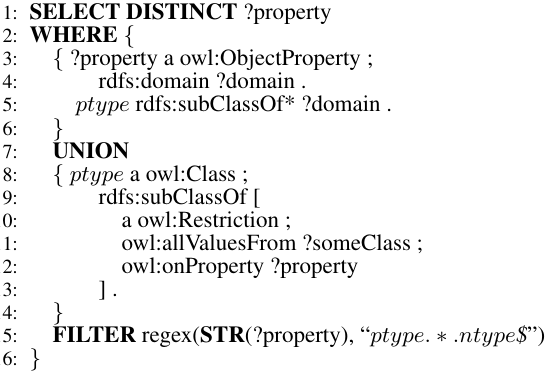
Algorithm 1 looks through all nodes of a given city model